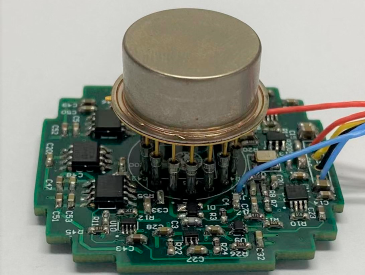
Table 2. Unloaded resonant frequency of accelerometer resonator (kHz).